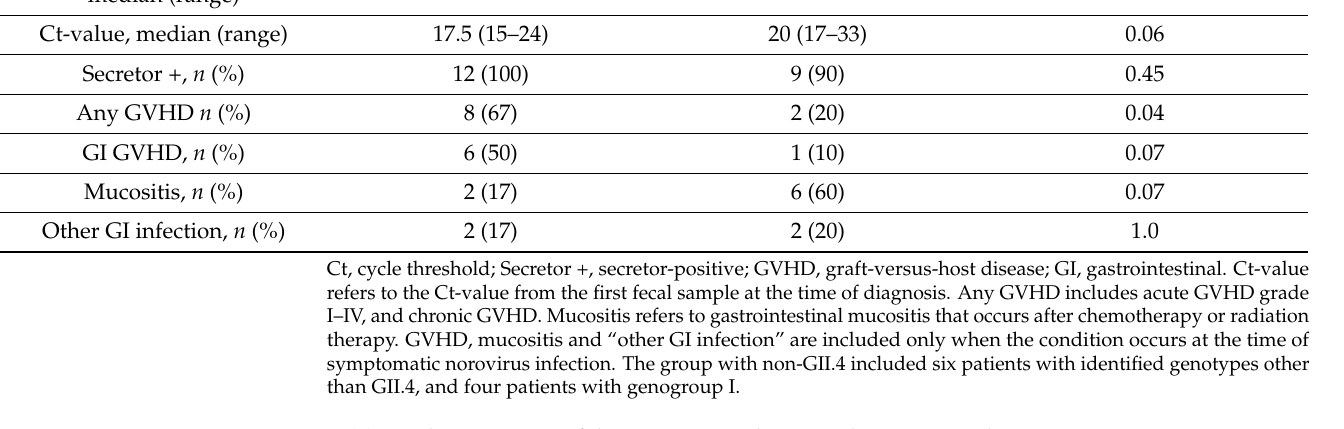
Table 3. Characteristics of the patients in relation to the symptom